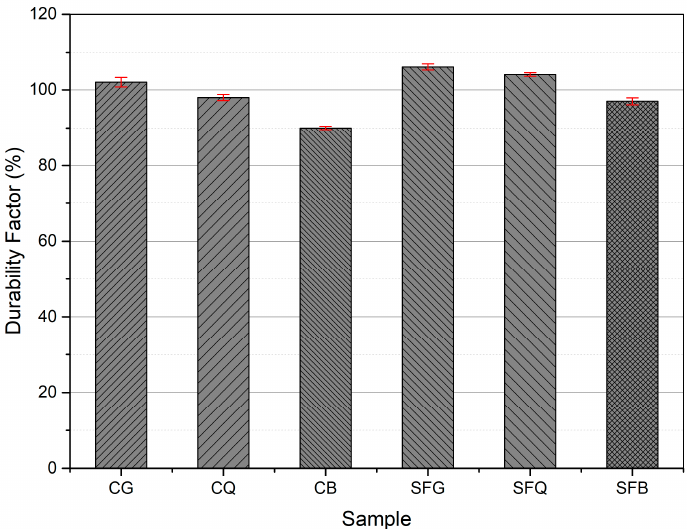
Figure 6. Durability factors for concrete specimens after freezing and thawing.